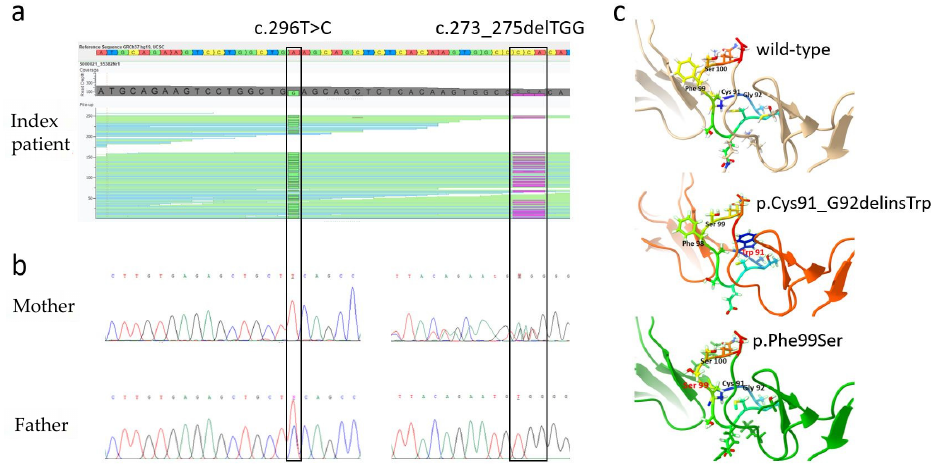
Figure 3. Molecular genetics of the (familial) case of anonychia congenita. ( a ) Golden Helix Genome- Browse analysis of the WES results showing the two probably pathogenic RSPO4 variants c.296T>C and c.273_275delTGG (reverse complement DNA sequence) of the compound-heterozygous index patient; ( b ) Chromatograms of the parents’ Sanger sequencing results displaying the heterozy- gous carrier status of mother and father for RSPO4 c.273_275delTGG and c.296T>C, respectively; ( c ) Predicted three-dimensional structures of wild-type RSPO4, mutant p.Cys91_Gly92delinsTrp and p.Phe99Ser